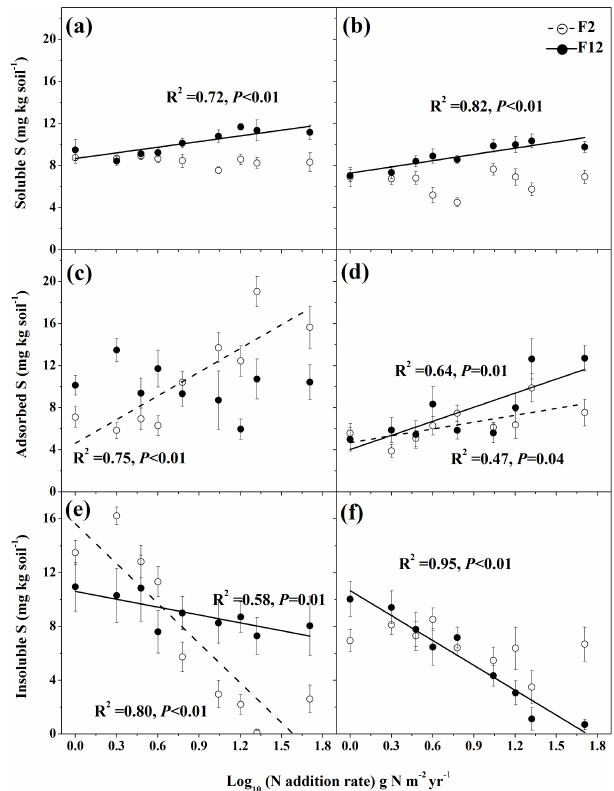
Figure 2. Effects of N addition intensity and frequency on concen- trations of soil-soluble S (a, b) , adsorbed S (c, d) , and insoluble S (e, f) in unmown (a, c, e) ) and mown plots (b, d, f) . Dashed and solid regression lines represent 2 and 12N additions per year, re- spectively. Error bars indicate standard